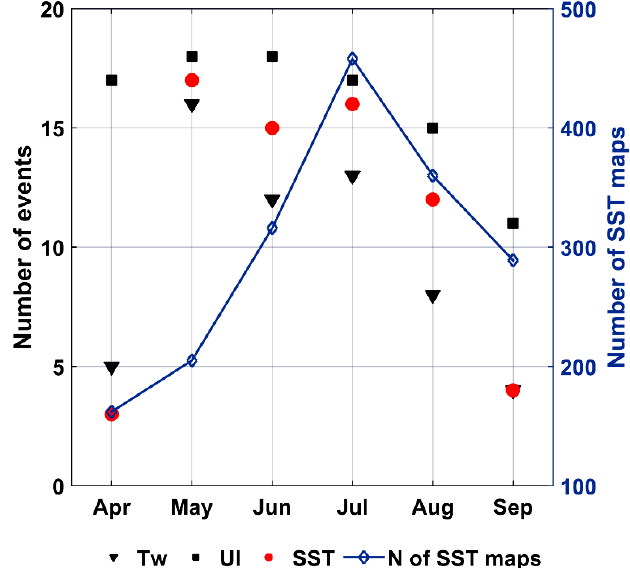
Figure 2. Overall number of upwelling events identified in the satellite infrared (IR) imagery (denoted as SST, for sea surface temperature), from the water temperature (T w ) measurements at the Klaipeda monitoring station and based on the upwelling index (UI) in the SE Baltic Sea from April to September 2000–2015. The blue line with diamonds shows the number of satellite images available per month.